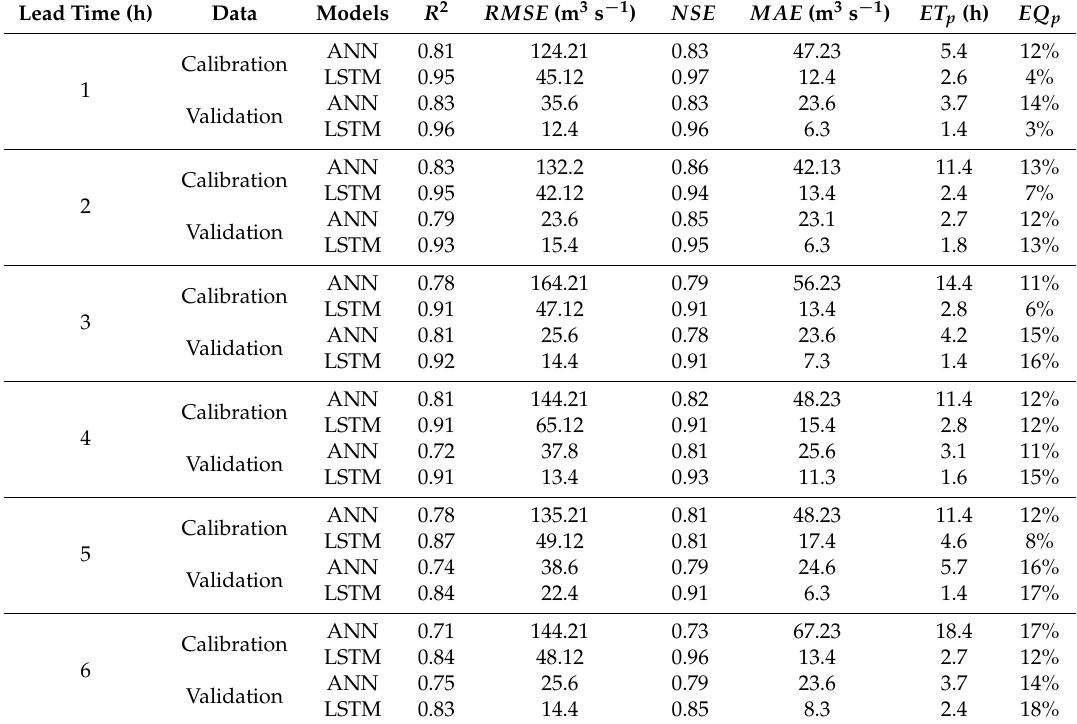
Table 3. The performances of runoff forecasting at different lead times (1–6 h) by ANN and LSTM model for series flood